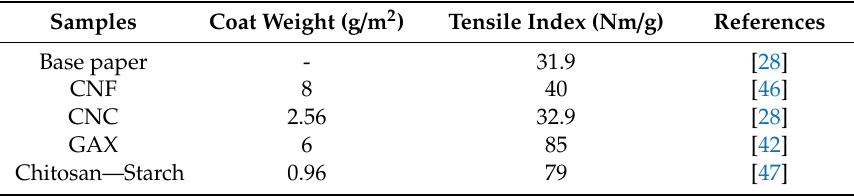
Figure 4. SEM images of paper surface ( a , c , e ) with magnitude ×500 and cross-sections ( b , d , f ) with magnitude ×1000 for uncoated paper and paper coated with AX and GAX with coating weight of 12 g/m 2 . ( a , b ) uncoated paper; ( c , d ) unmodified AX coated paper; ( e , f ) GAX coated paper [6] (Reprinted by permission from: Springer, Cellulose, Glutaraldehyde crosslinking of arabinoxylan produced from corn ethanol residuals, Xiang, Z.; Anthony, R.; Lan, W.; Runge, T., 2016). Table 1. Mechanical properties of polysaccharide-coated paper.